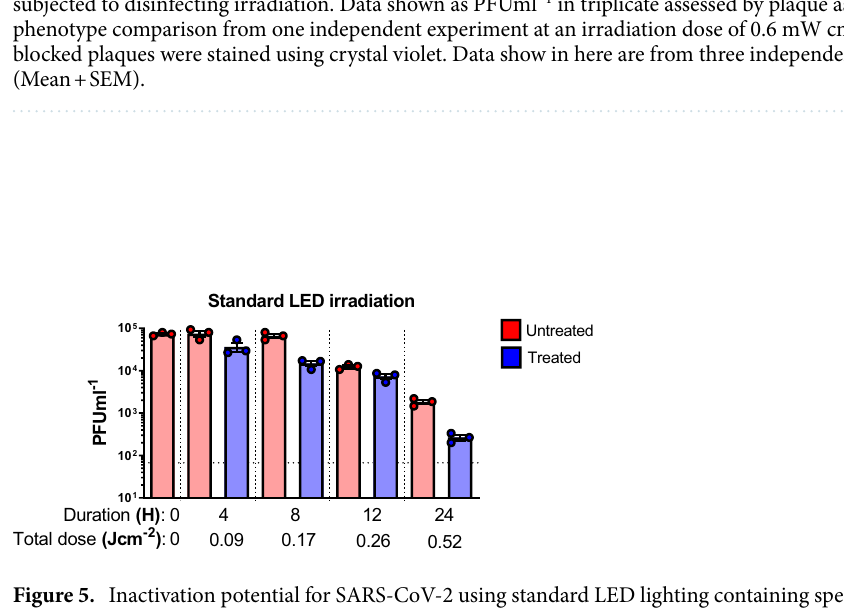
Figure 5. Inactivation potential for SARS-CoV-2 using standard LED lighting containing spectral wavelengths from 400 to 420 nm. Standard LED lights were used to irradiate samples over a course 24 h while sampling at 4, 8, 12 and 24 h (done in independent triplicates). Blue bars indicate treated samples and red bars correspond to the untreated equivalent that was left at the biosafety cabinet under the same conditions while not subjected to disinfecting irradiation. Data shown as PFUml −1 in triplicate assessed by plaque